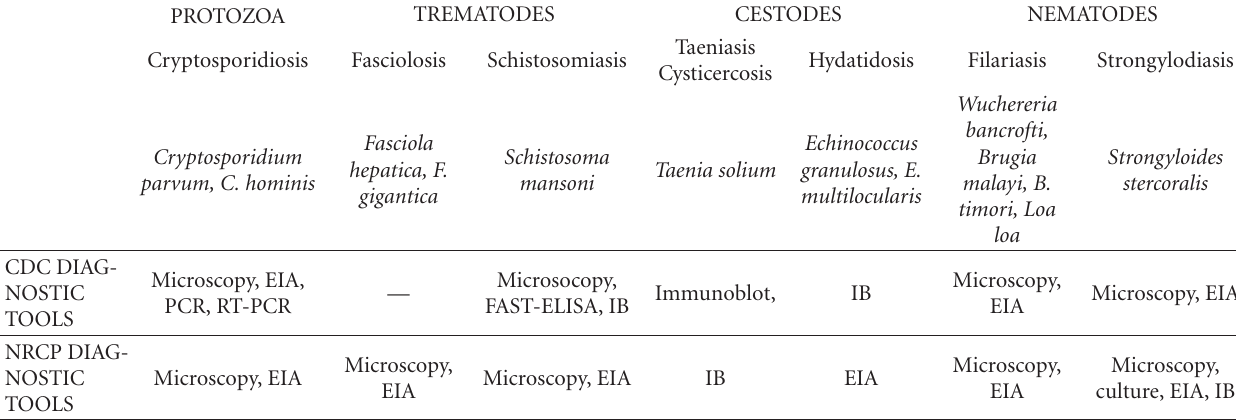
Table 4: Diagnostic tools for the detection of specific intestinal parasitic diseases o ff ered by the CDC and the